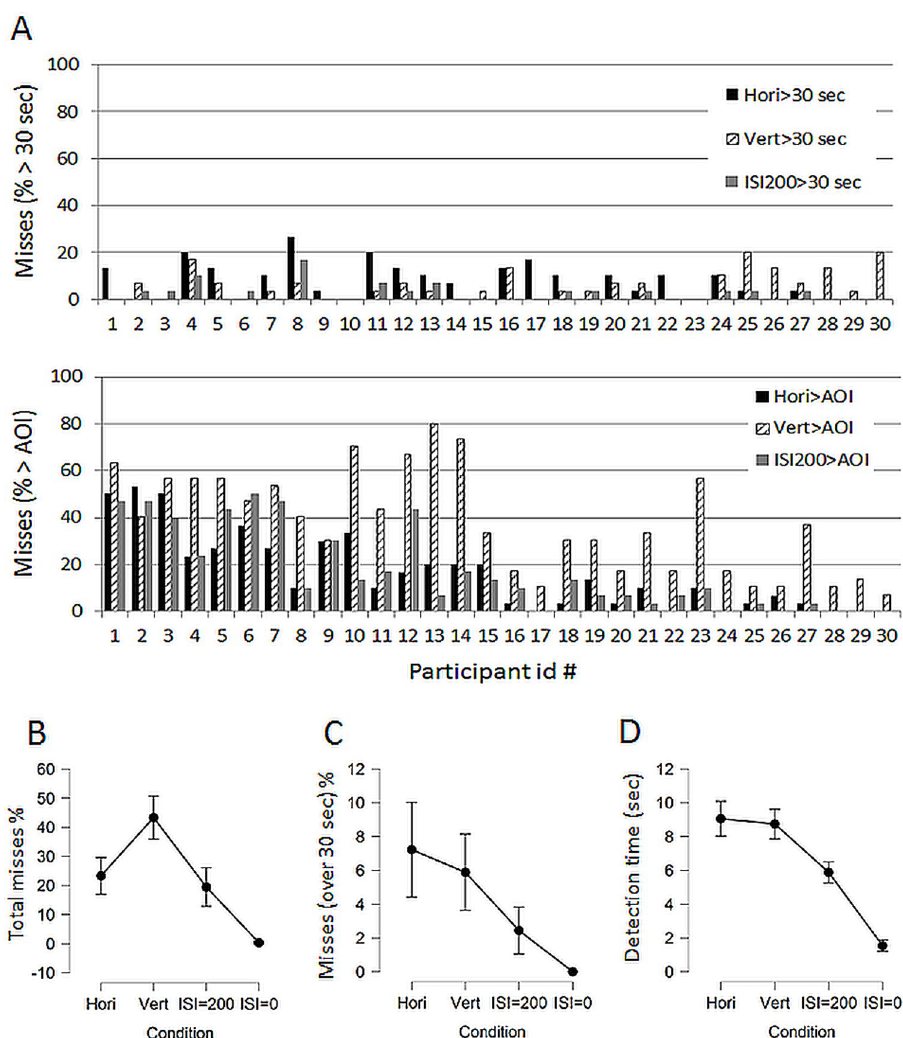
Fig 2. Individual and group performance. A. Individual percentage of misses made in the horizontal, vertical, and ISI = 200 conditions. Top: misses due to failure to detect any deviation within the 30 sec time limit (Change blindness). Bottom: misses due to marking outside the AOI (that is > 1 cm from the target) when detection is reported. Individuals in the graphs are sorted contingent on the total number of misses (sum of failed detections within 30 sec and markings outside the AOI) in the horizontal condition. (B) The group level average total percentage of misses is displayed where no target was detected within the 30 seconds time limit or the markings were made outside the area of interest (AOI). (C) The group level misses consisting of no target detected within 30 seconds, i.e. change blindness, are selectively shown. (D) Detection times in seconds for trials were the markings were made within the AOI ( < 10 mm from the target centre). The 95% CI are